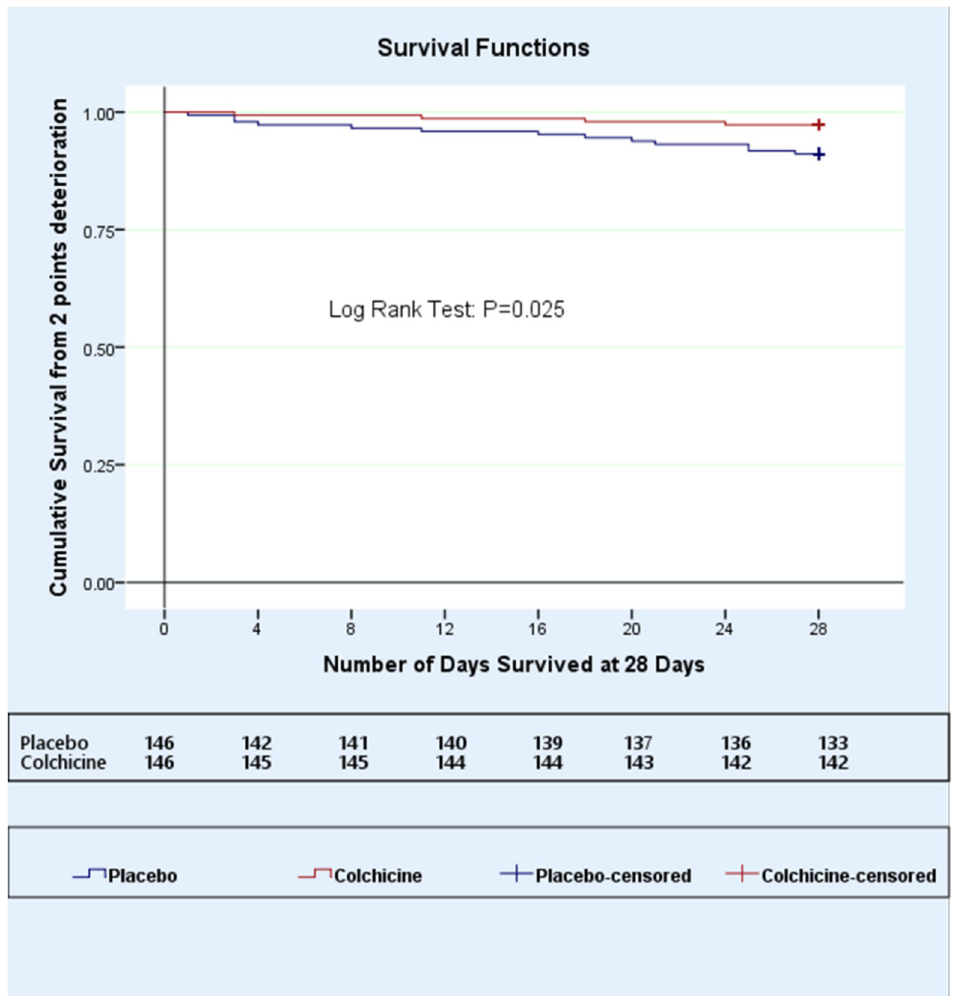
Fig 3. Kaplan-meier survival curve on Day 28 of follow-up using the log-rank test.